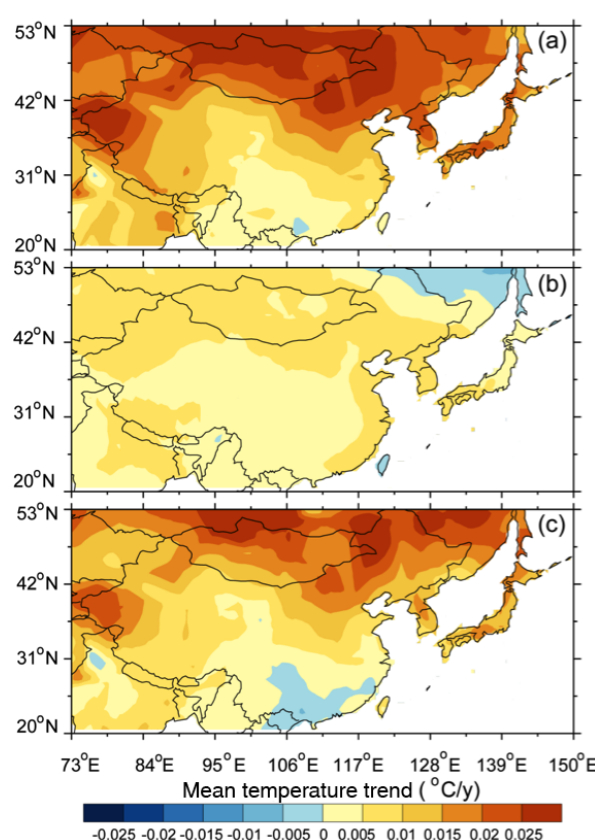
Figure 3. Spatial distribution of cold season trend of raw (a) , dy- namically induced (b) , and radiatively forced (c) temperatures from 1902 to 2011 over east